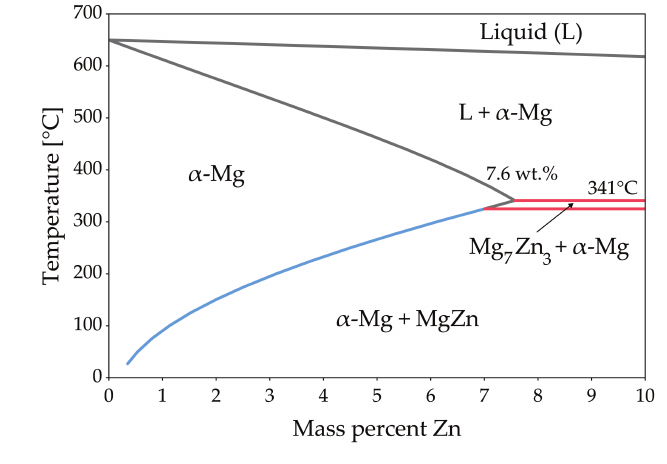
Figure 21. Phase diagram of the Mg-Zn system. For further information, see Appendix